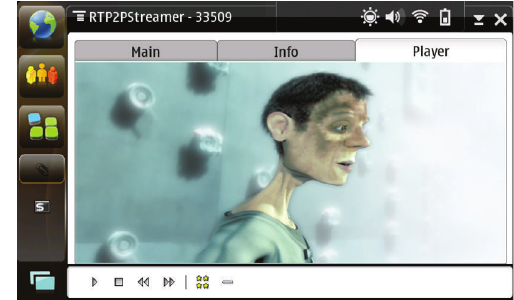
Figure 11: Graphical user